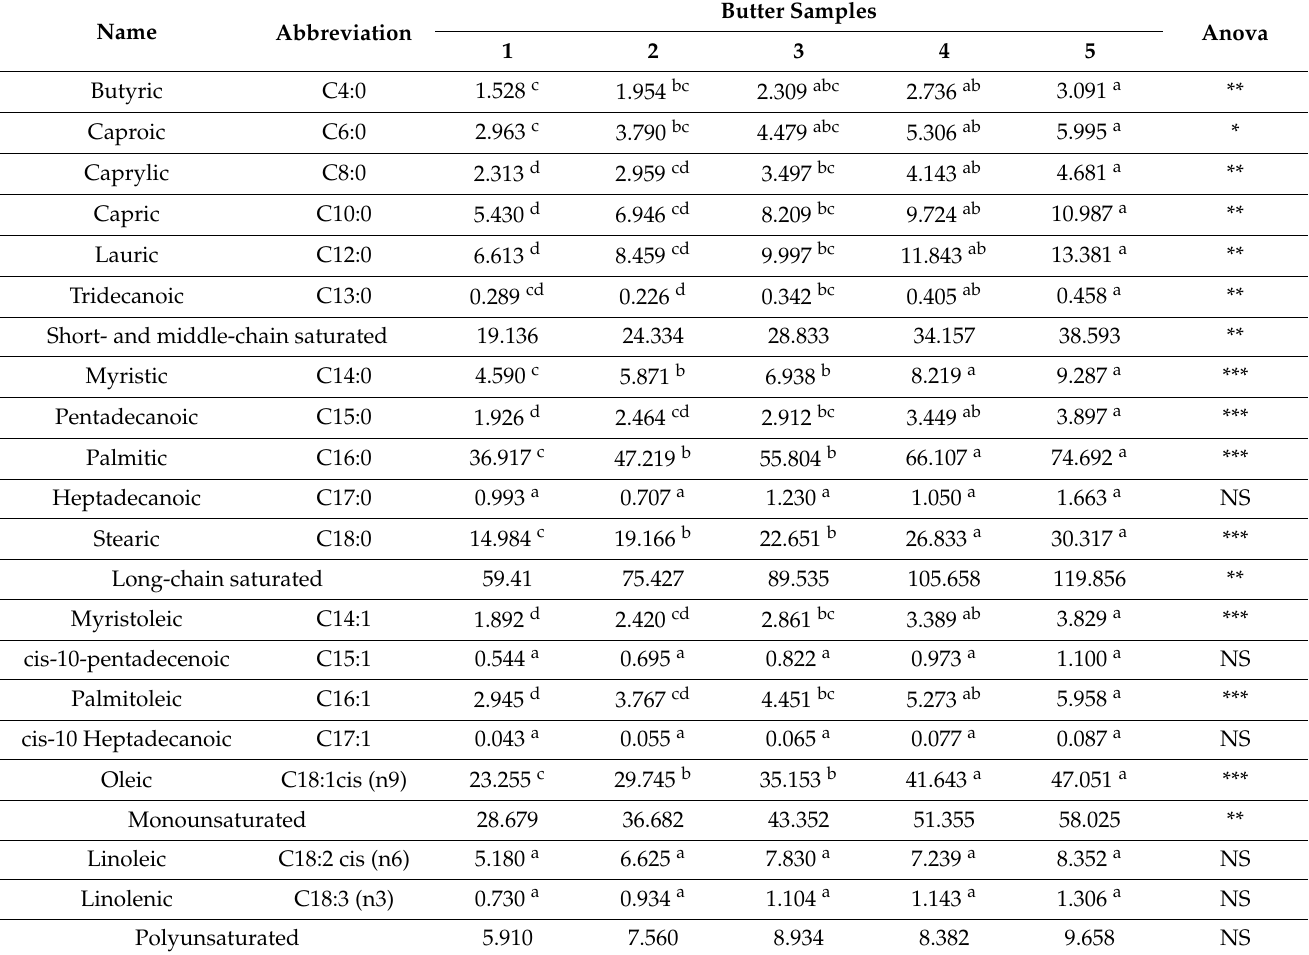
Table 5. Fatty acids concentration ( µ g/mg) of butter samples.